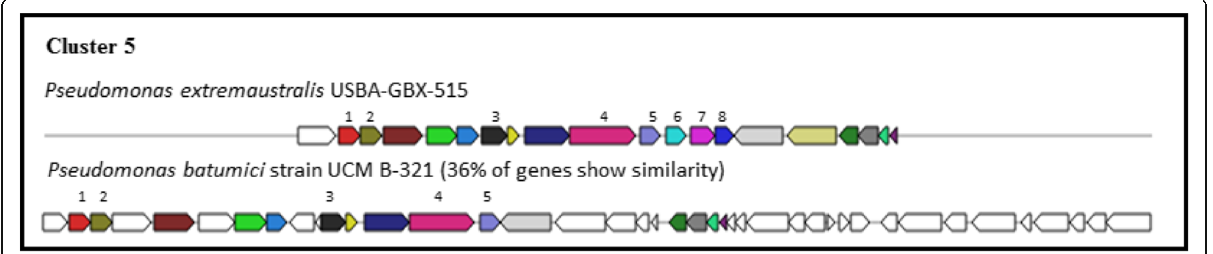
Fig. 8 Genetic map of glidobactin biosynthetic gene cluster 5 detected by AntiSMASH 3.0. The genes were designated by colors. Same color means equal genes in different strains; not colored means other genes. 1. ABC transporter permease; 2. ABC transporter ATP-binding protein; 3. prolyl aminopeptidase; 4. glu- can biosynthesis glucosyltransferase; 5. amino acid ABC transporter substrate-binding protein; 6. ABC transporter, PAAT family; 7. ABC transporter permease; 8.